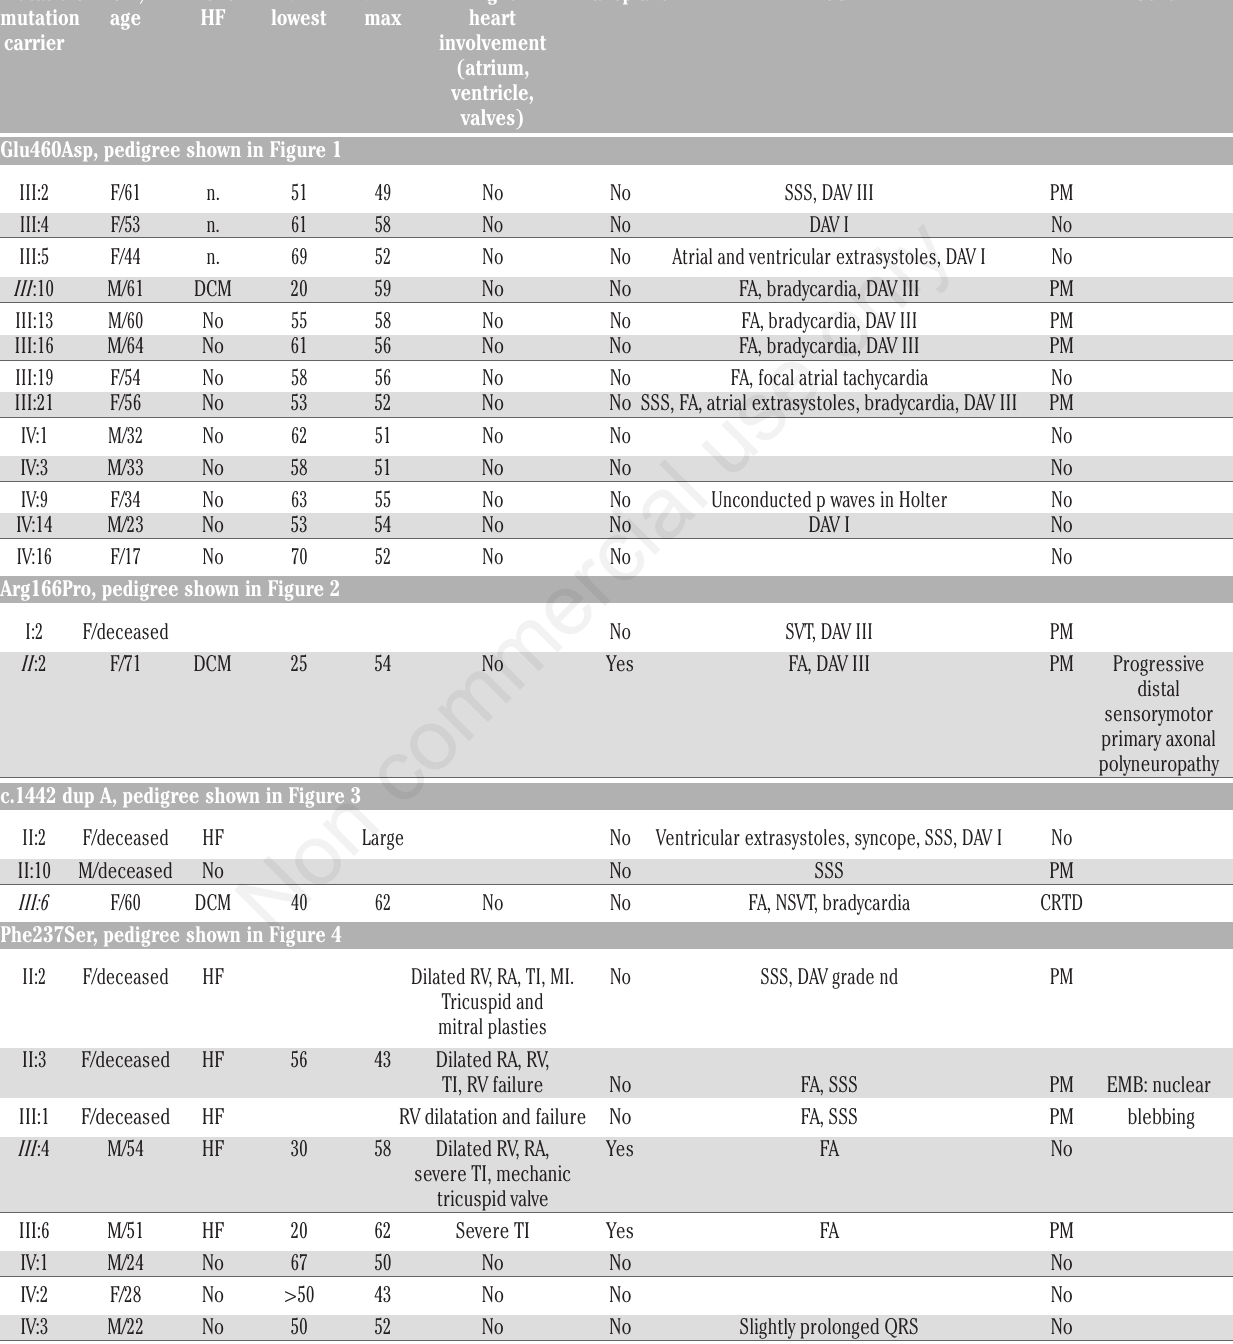
Table 1. The clinical manifestations associated with the LMNA mutations Glu460Asp, Arg166Pro, c. 1442 dup A and Phe237Ser. Probands are marked in italics. Mutation/ F/M,